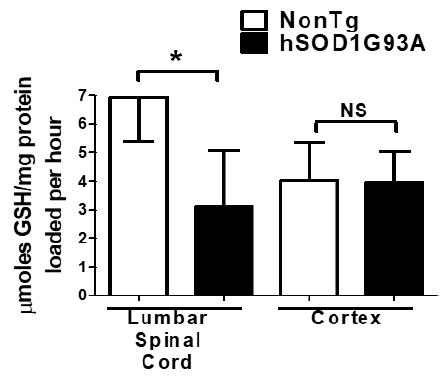
Figure 4. GSH loading is diminished in mitochondria isolated from G93A mutant SOD1 spinal cord. Isolated lumbar spinal cord or cerebral cortex mitochondria from G93A mutant hSOD1 and littermate NonTg control mice were incubated with 2 mM GSH for 4 h. Samples were washed and GSH was measured using a DTNB assay. Mean ± SEM; NS = not significant, * p < 0.05 versus NonTg control, as determined by unpaired Student’s t -test, n = 4.